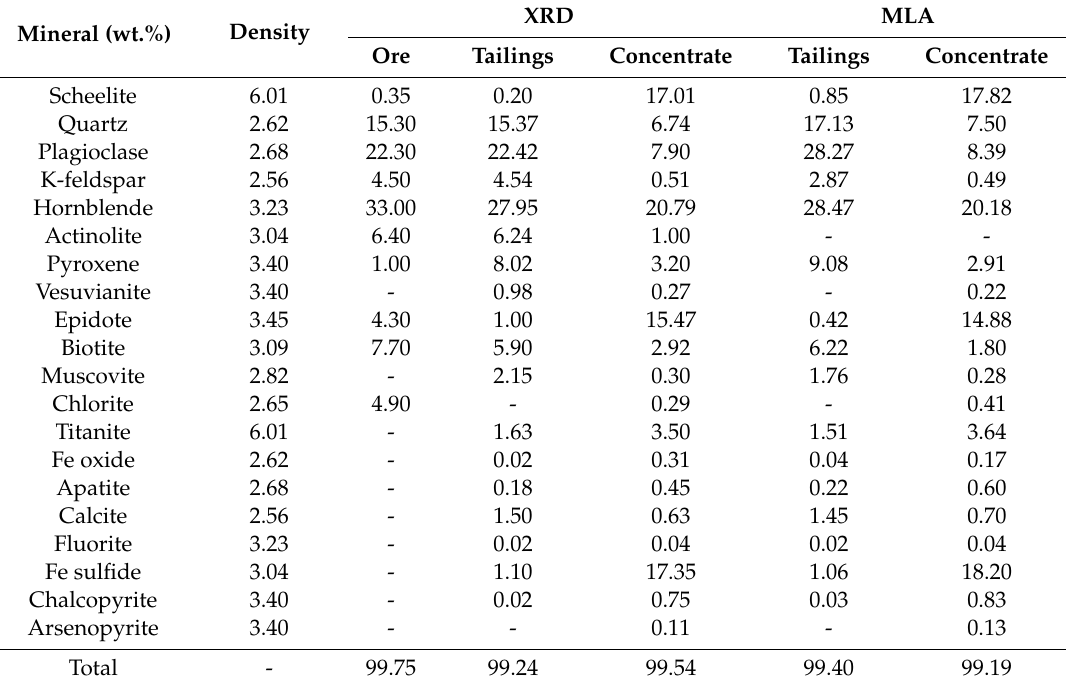
Table 3. Modal mineralogy of the whole sample, concentrate, and tailings determined by X-ray powder di ff raction (XRD) and mineral liberation analysis (MLA). Mineral